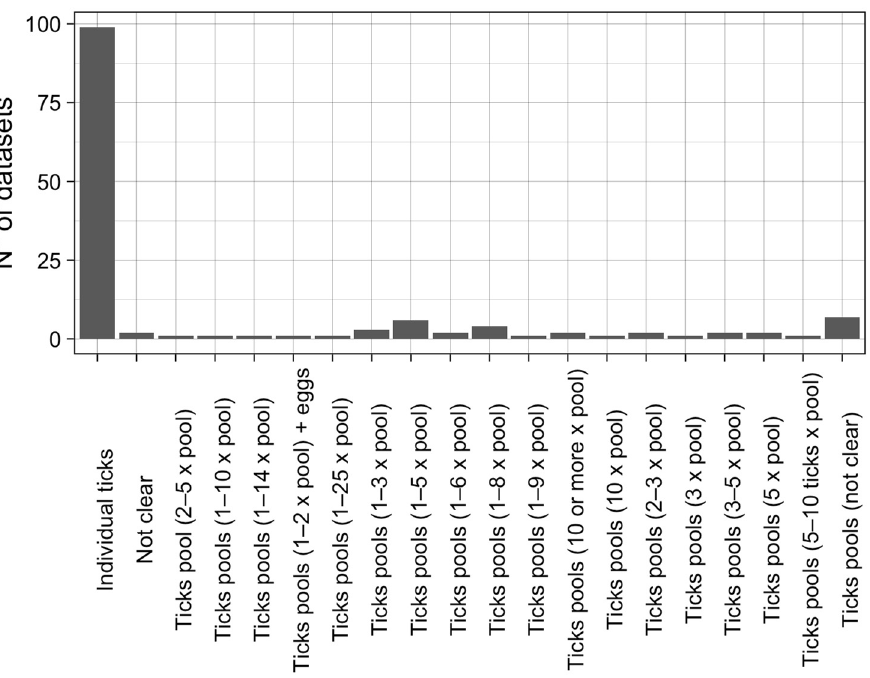
Figure 3. Number of datasets grouped per the variable sample type (individual ticks vs. pooled ticks).